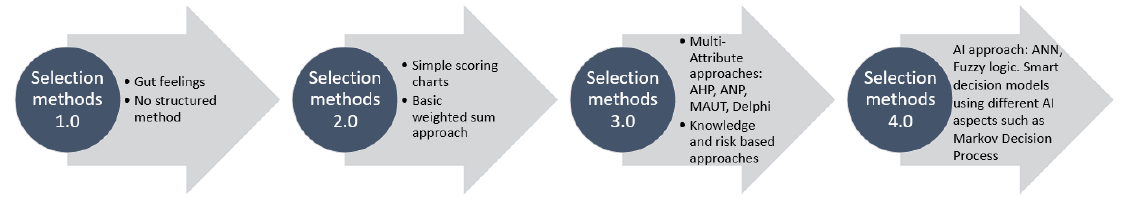
Figure 7. Evolution of project delivery selection methods. Table 3. Overview of project delivery selection methods.